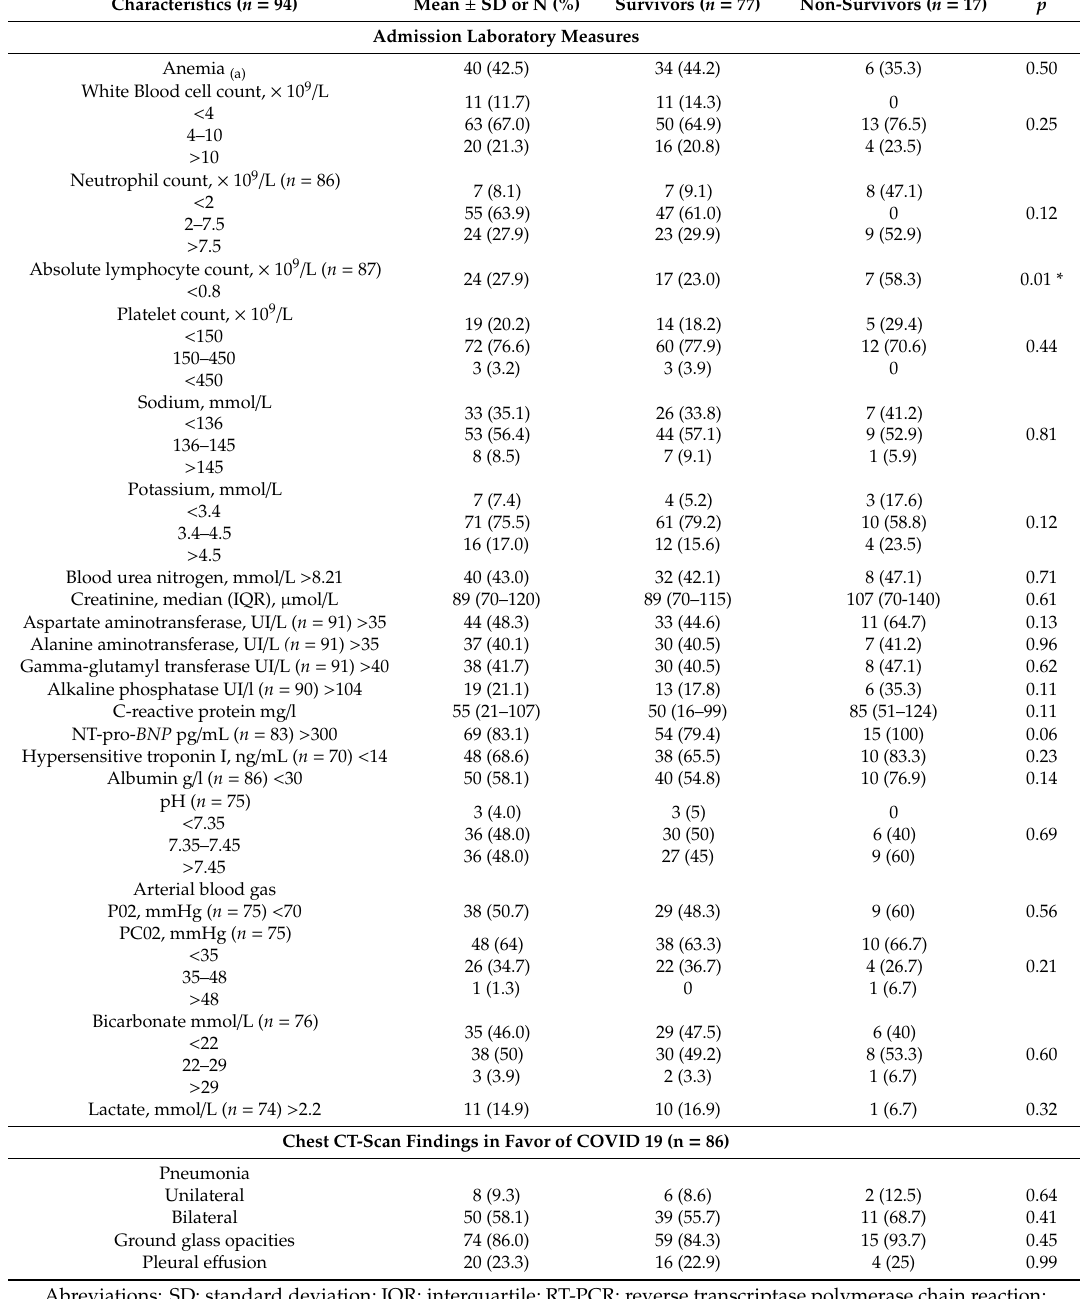
Table 3. Complementary exams of older patients with